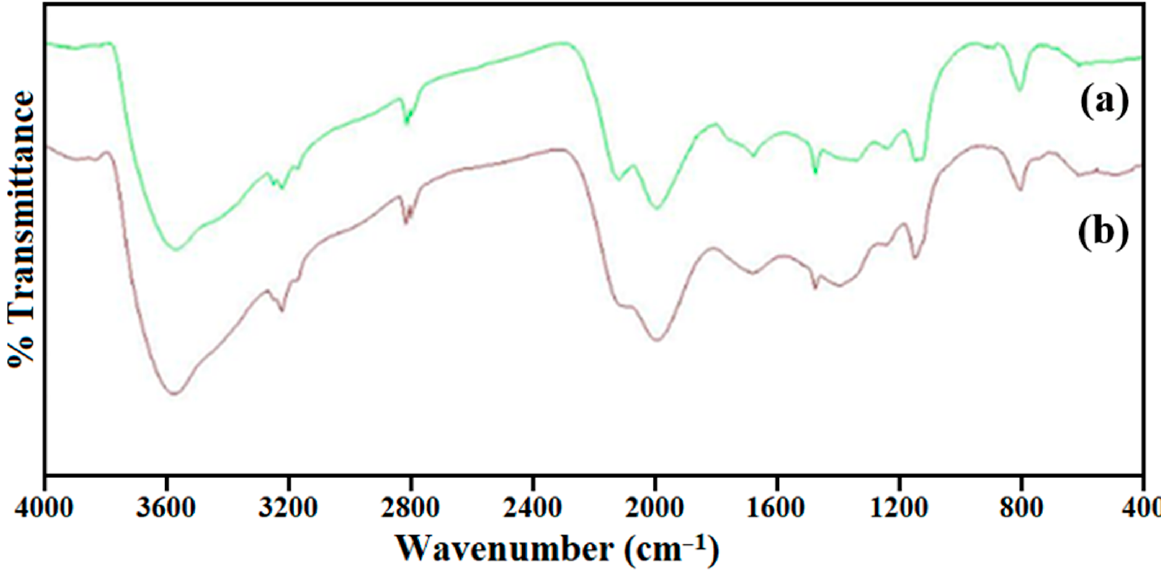
Figure 1. FT-IR spectra of Al-GNSC: ( a ) before, and ( b ) after Cr(VI) adsorption.